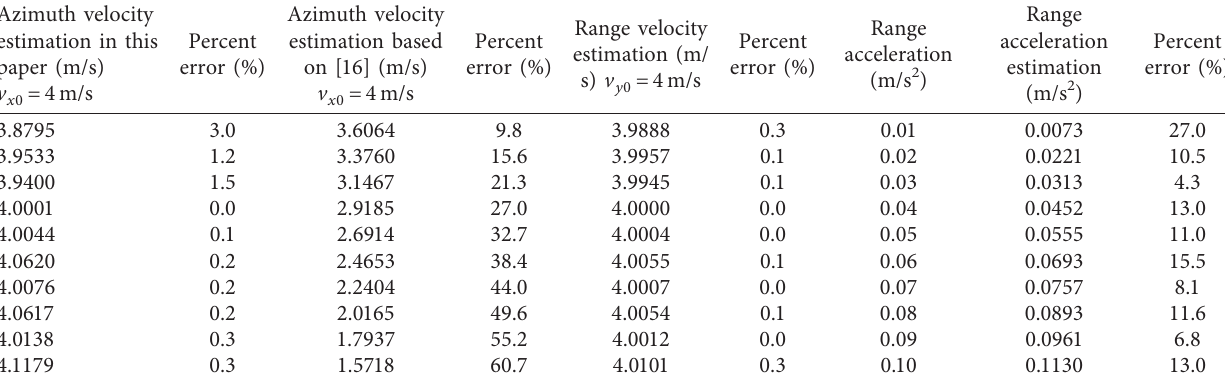
� 4 m/s and a � 0.1m/s 2 . x 0 y 0